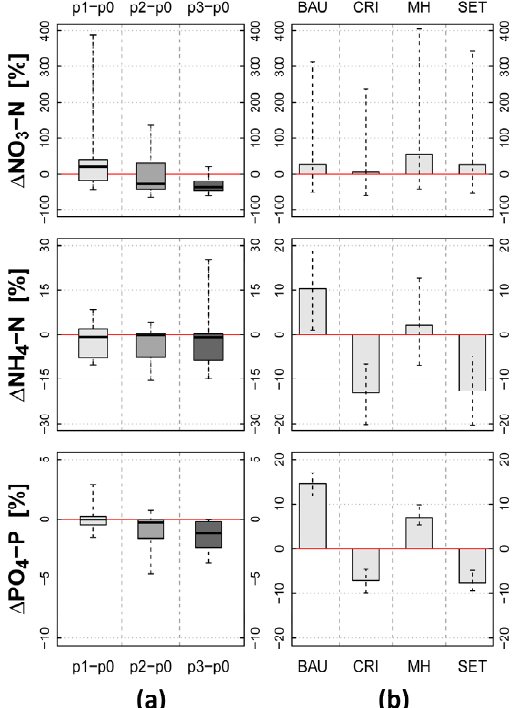
Figure 10. Long-term average annual changes in nitrate nitrogen (NO 3 -N), ammonium nitrogen (NH 4 -N) and phosphate phosphorus (PO 4 -P) loads to the lagoon shown as boxplots. ( a ) Climate change impacts, showing results for the three future scenario periods (p1, p2 and p3) compared to the reference period (p0); ( b ) Combined, climate and socio-economic impacts showing results for each of the four socio-economic scenarios (BAU, CRI, MH and SET) compared to the reference